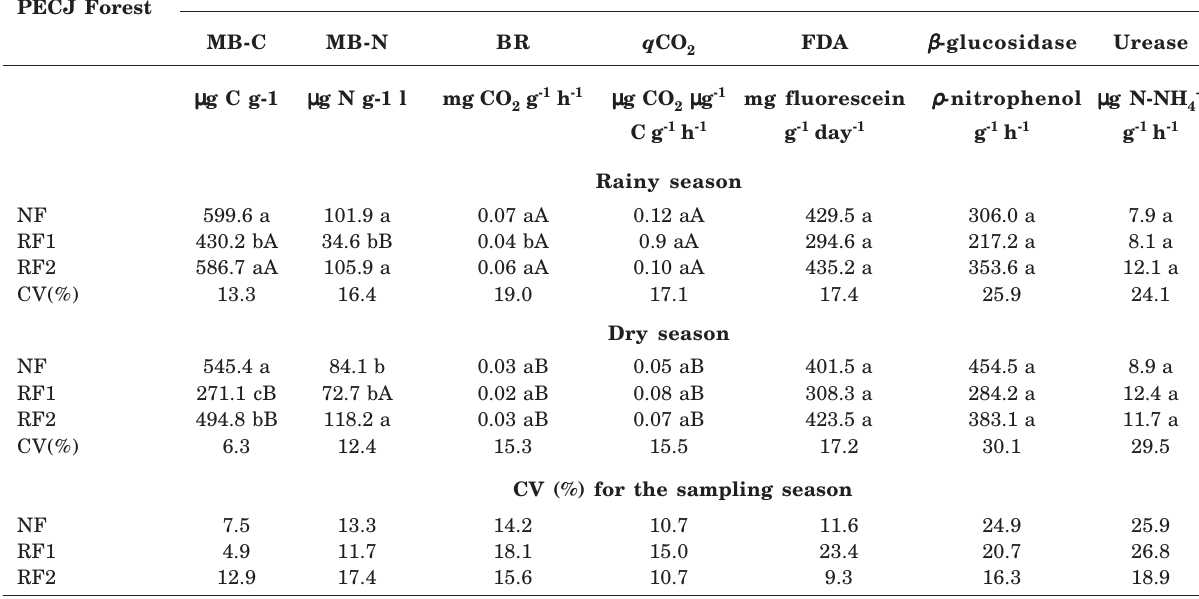
Table 5. Biochemical properties of the soil: microbial biomass carbon (MB-C), microbial biomass nitrogen (MB-N), basal respiration (BR), metabolic quotient ( q CO 2 ), fluorescein diacetate hydrolysis (FDA), βββββ - glucosidase, and urease of the following PECJ forests: natural forest (NF), replanted forest 1 (RF1), and replanted forest 2 (RF2) in the rainy and dry